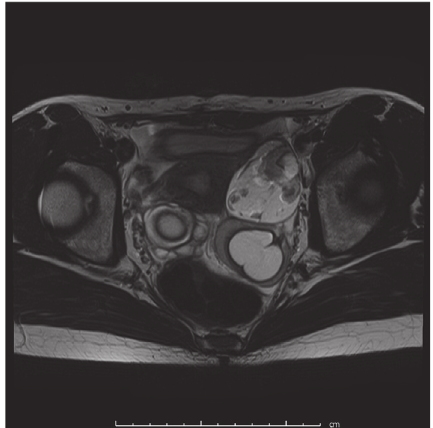
Figure 2: Pelvic magnetic resonance imaging (T2-weighted image) before the second surgery of Case 2. Bilateral ovarian tumors are detected (right side: 4.4 cm, left side: 8.0 cm in diameter).